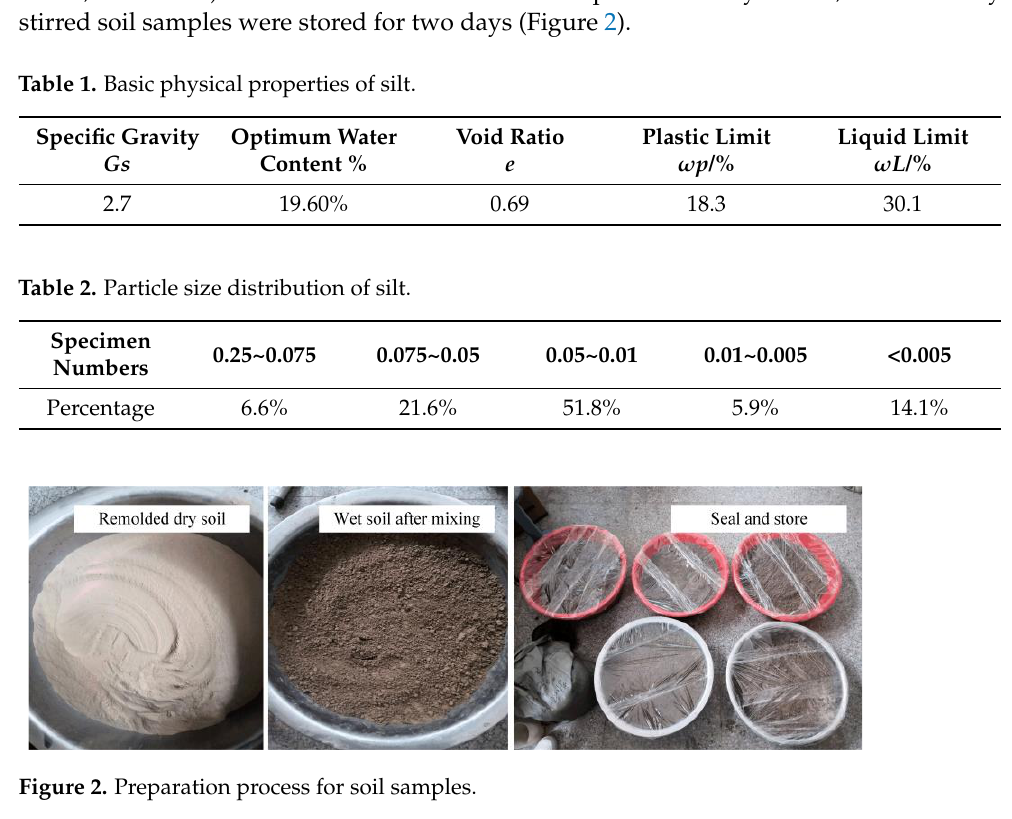
Figure 1. Large-scale shear instrument.